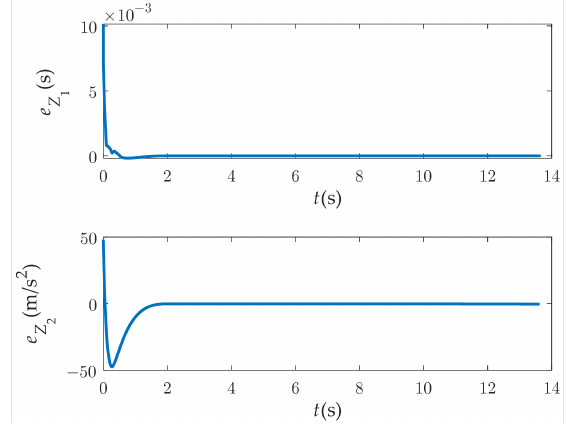
Figure 11. Tracking error of DDOB.